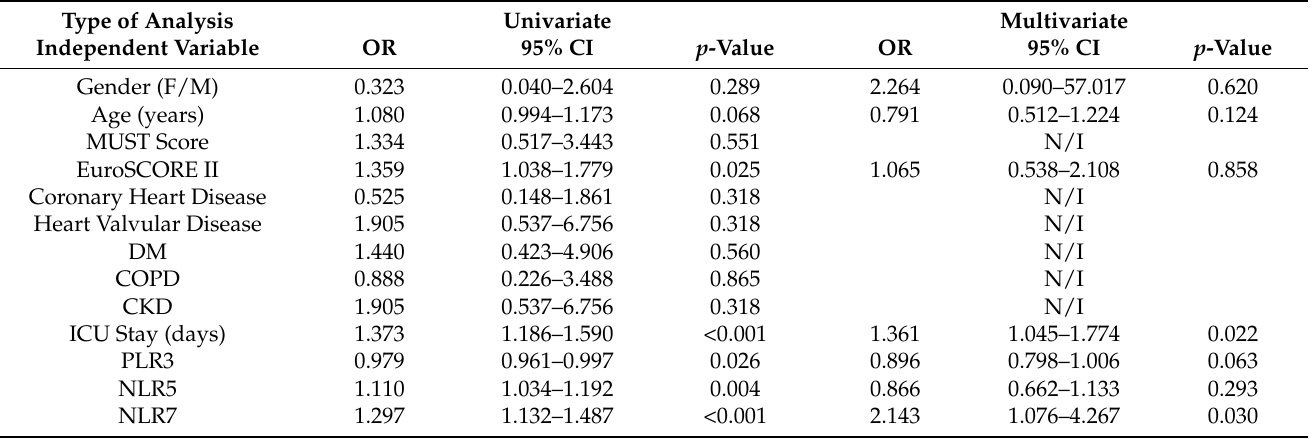
Table 4. The results of the uni- and multivariate analysis for identifying potential independent risk factors for